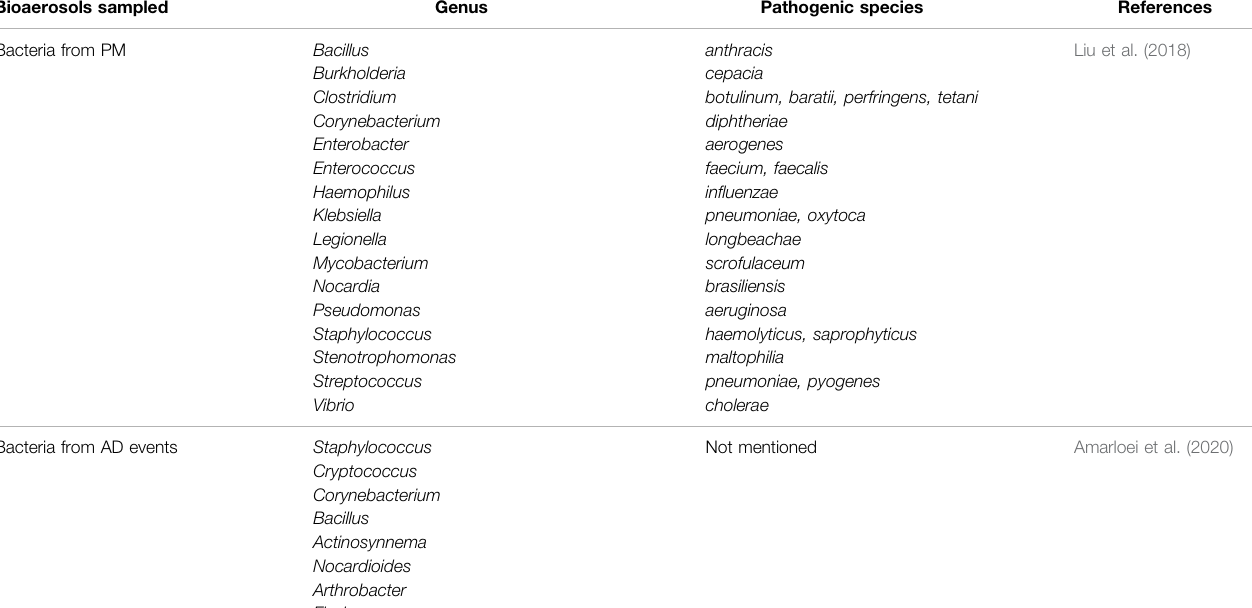
TABLE 4 | Pathogenic bacterial and fungal genus and species detected in PM and dust samples. Bioaerosols